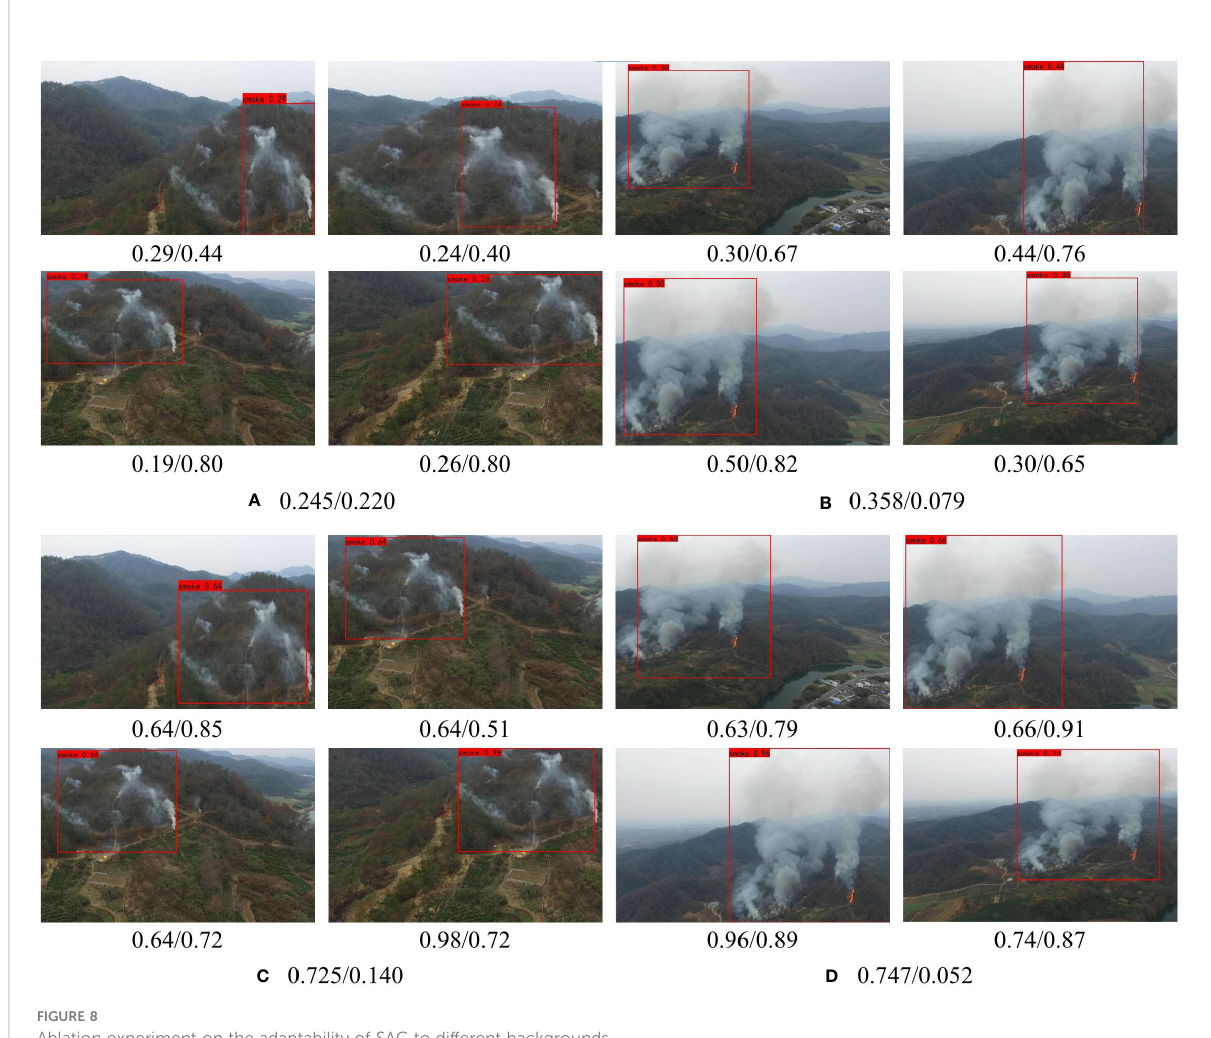
FIGURE 8 Ablation experiment on the adaptability of SAC to different